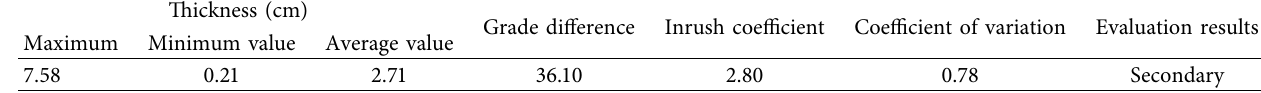
Table 5: Tracer production channel thickness coefficient of injection production